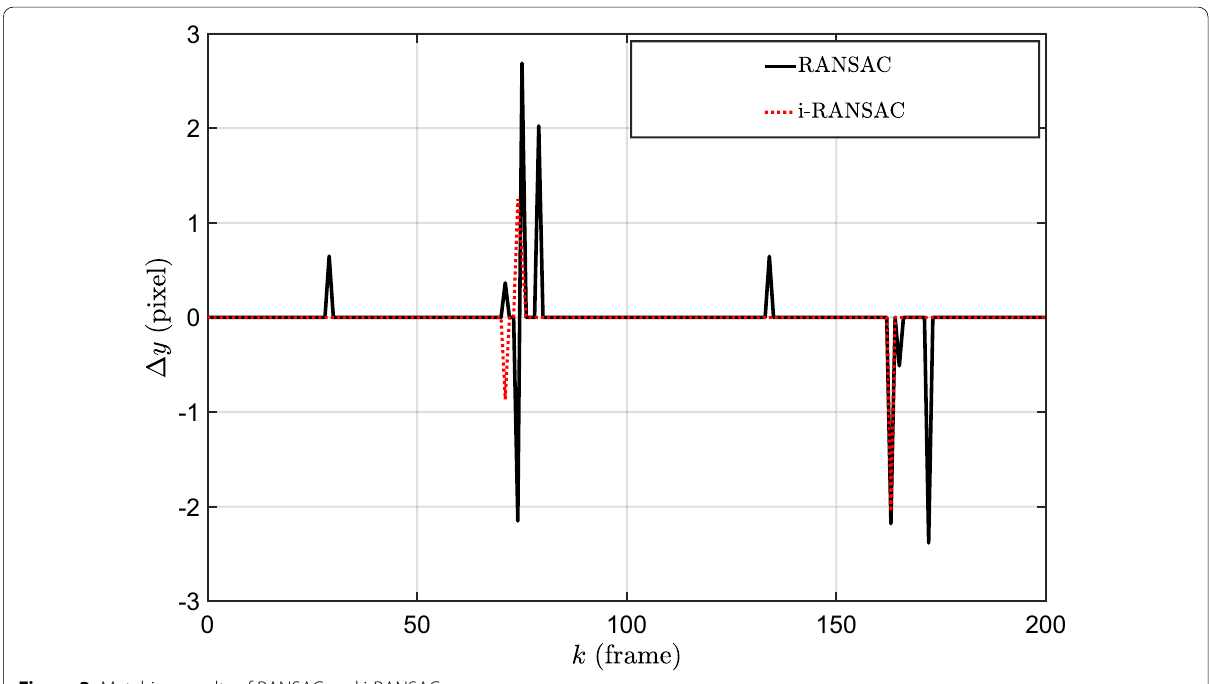
Figure 3 Matching results of RANSAC and